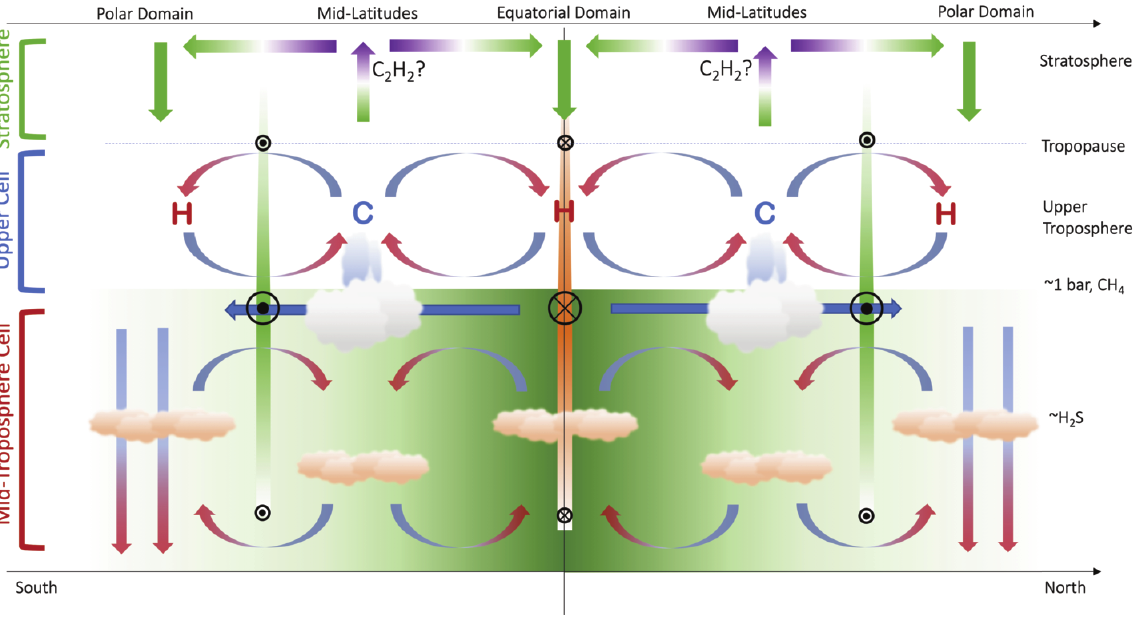
Figure 23. Sketch of the meridional circulation on Uranus and Neptune. The upper tropospheric cell is similar to the earlier models, but a second layer of cells with an opposite sign is hypothesized to be present below this layer, so all observed quantities can be explained. The green equator-to- pole shading represents the gradient in H 2 S and CH 4 . Small-scale rising at high latitudes in the mid-tropospheric cell may explain the existence of polar clouds. Retrograde winds are indicated by orange bars and circles with crosses; prograde winds are indicated by green bars with circles with dots